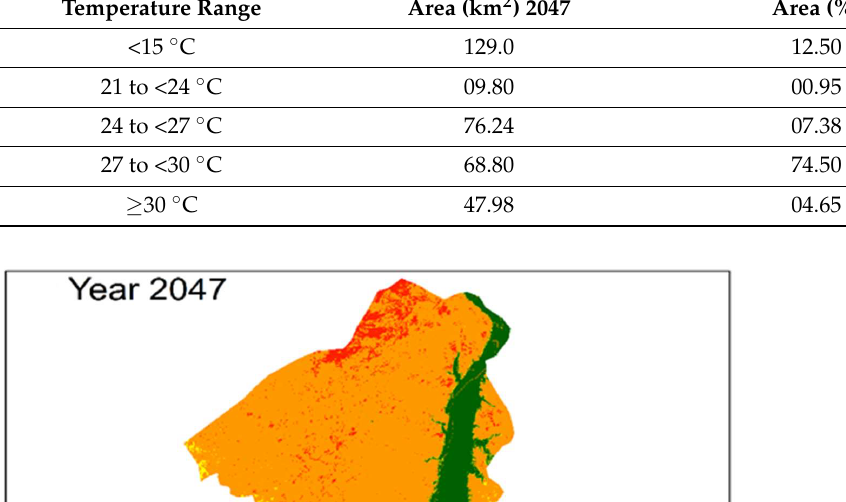
Table 6. LST Simulation for the 2047.